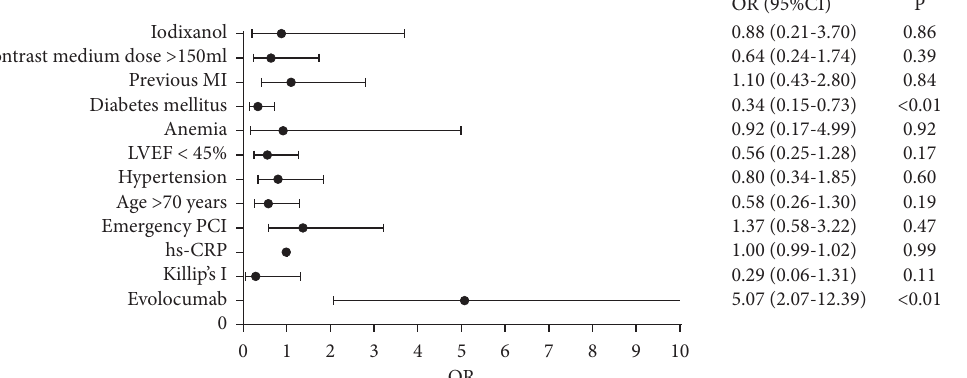
Figure 1: Logistic regression analysis of patients with acute myocardial infarction undergoing coronary intervention ( n � 309). OR, odds ratio; CI, confidence interval; hs-CRP, high-sensitivity C-reactive protein; PCI, percutaneous coronary intervention; LVEF, left ventricular ejection fraction; MI, myocardial